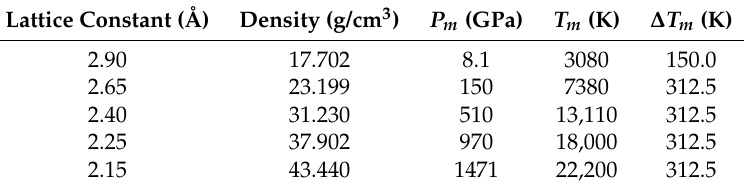
Table 2. The five ab initio melting points of dhcp-W, ( P m , T m ± ∆ T m ) , obtained from the Z method implemented with VASP: The lattice constant values correspond to the ideal dhcp structure.